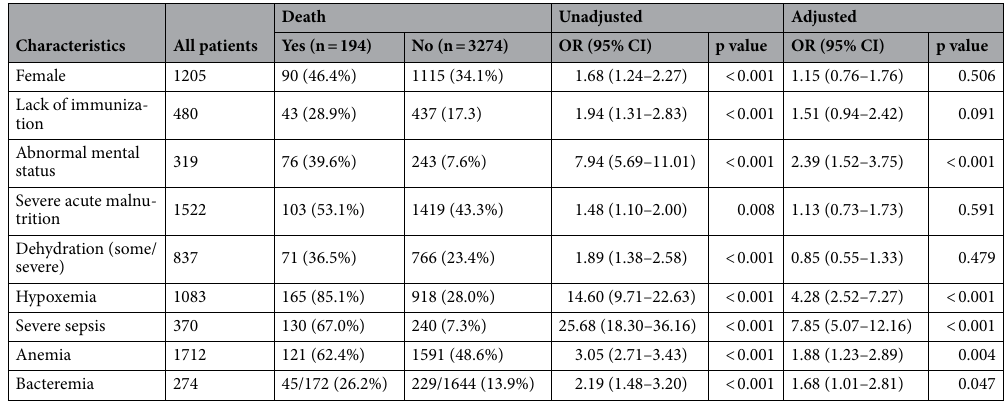
Table 3. Factors associated with deaths for under-five children hospitalized for pneumonia/severe pneumonia who had their hemoglobin done. OR odds ratio, CI confidence interval, () %.